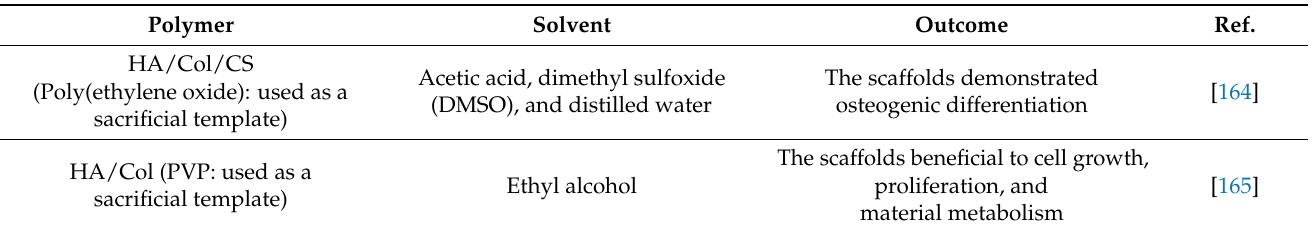
Table 2. List of some nanofibrous scaffold fabricated through electrospinning for bone regeneration. Polymer